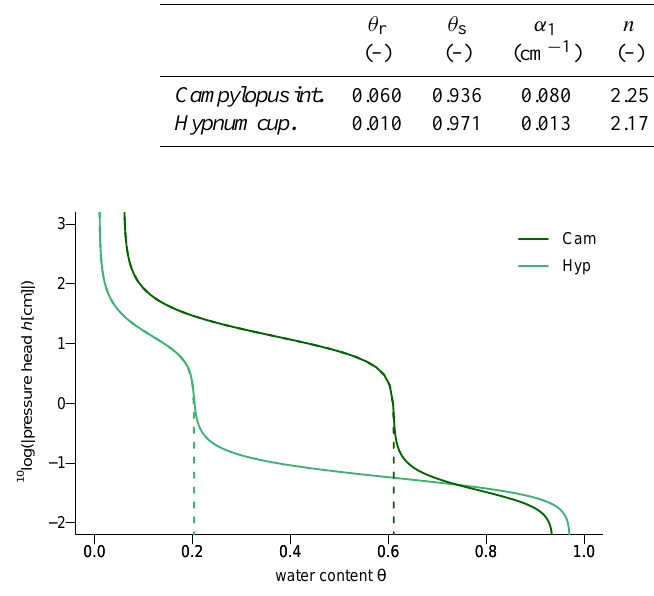
Figure A2. Hydraulic conductivity functions for two moss species: Campylopus introflexus and Hypnum cupressiforme . The dotted lines indicate the contribution of the capillary pore system, char- acterized by Voortman et al.